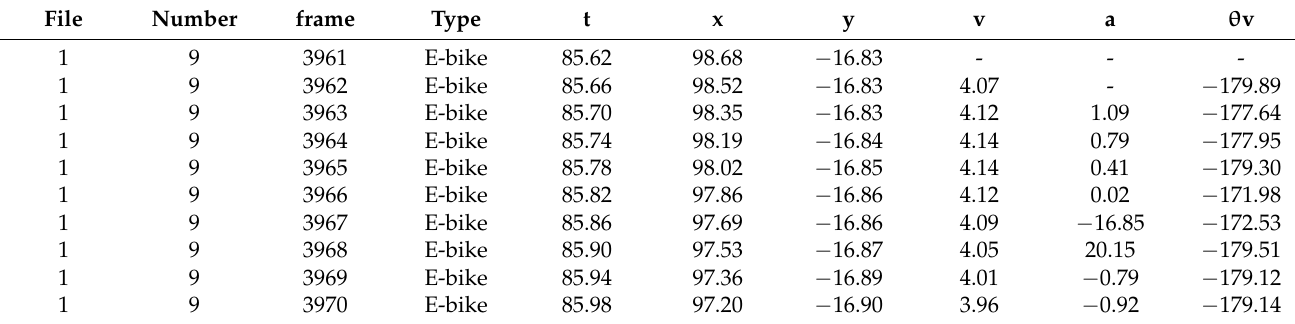
Figure 6. Smoothing process of speed. Part of the extracted trajectory data is shown in Table 2. Table 2. Trajectory information.